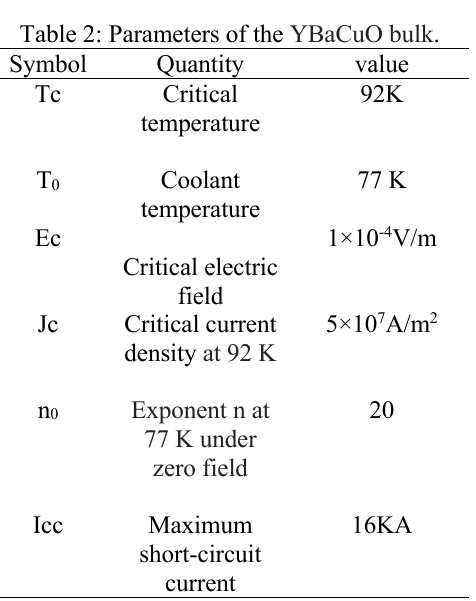
Table 2: Parameters of the YBaCuO bulk.